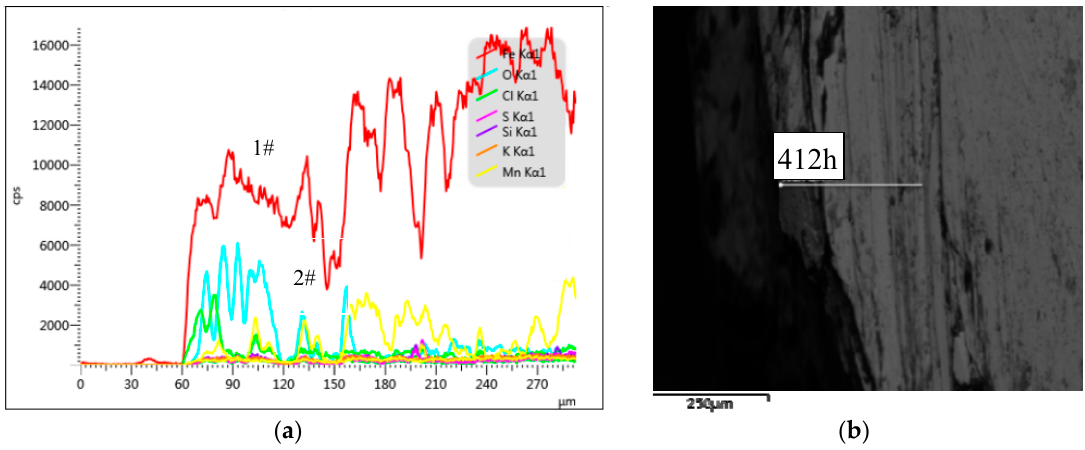
Figure 9. Group P20 line scan results. ( a ) The structure of steel corrosion products; ( b ) Micro-structure of corroded steel bars.